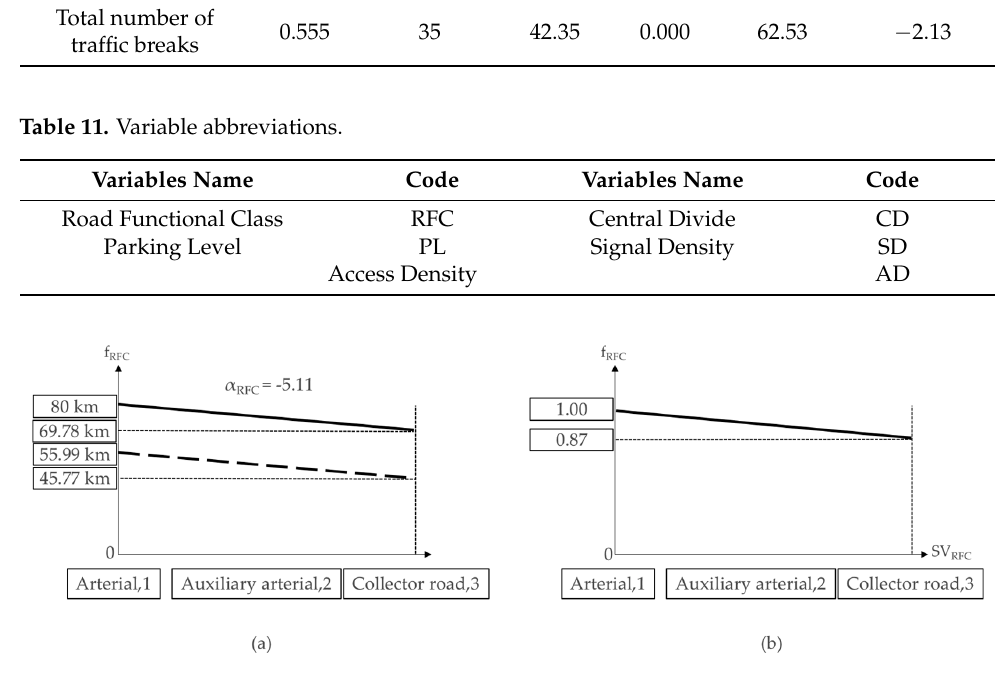
Figure 13. Adjustment factor development ( a ) and standardization for the existence ( b ) of road function.